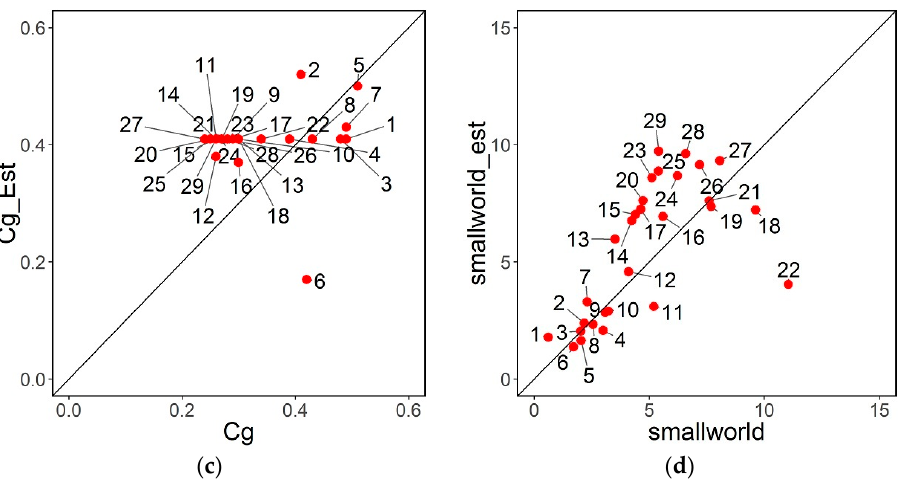
Figure 6. ( a ) Estimation of power distribution parameter; ( b ) Estimation of Lg; ( c ) Estimation of Cg; ( d ) Estimation of small-world-ness coefficient.